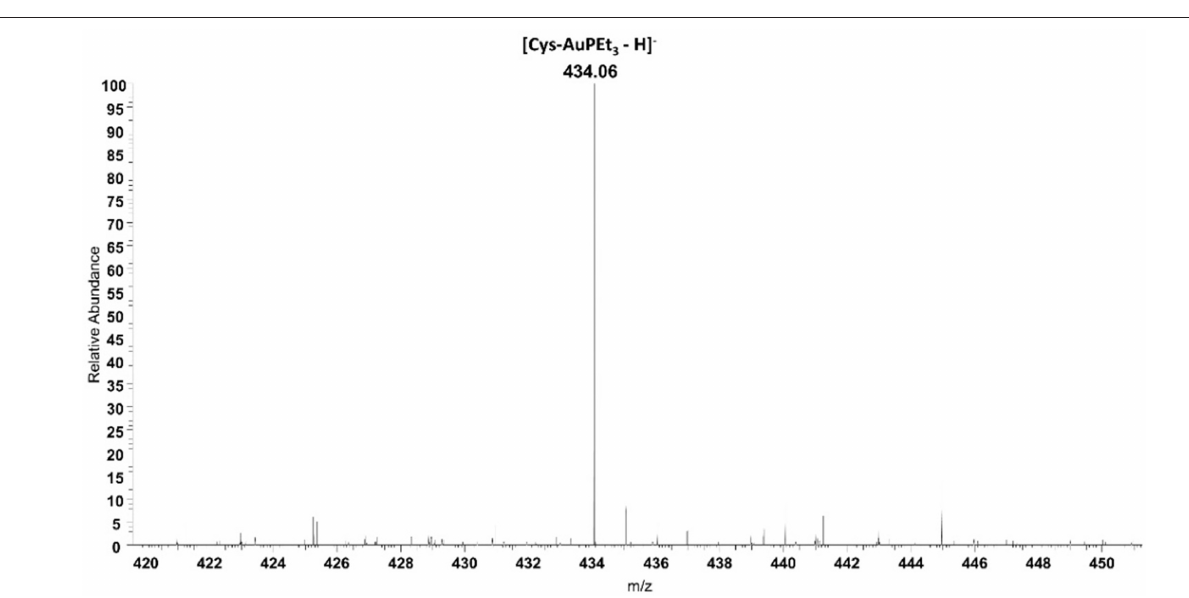
[AuPEt 3 ] + cation from AF and from its iodido derivative. In both cases the signal at 530.02 m/z is diagnostic for the Sec reactivity and assignable to the adduct with the [AuPEt 3 ] + moiety plus